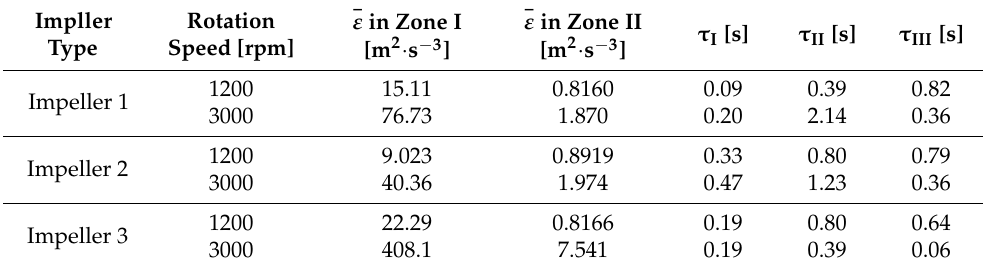
Figure 5. Mechanistic model zones. Red, orange, and green arrows represent suspension flow through zones I, II, and III respectively. Table 1. Averaged energy dissipation rate and residence